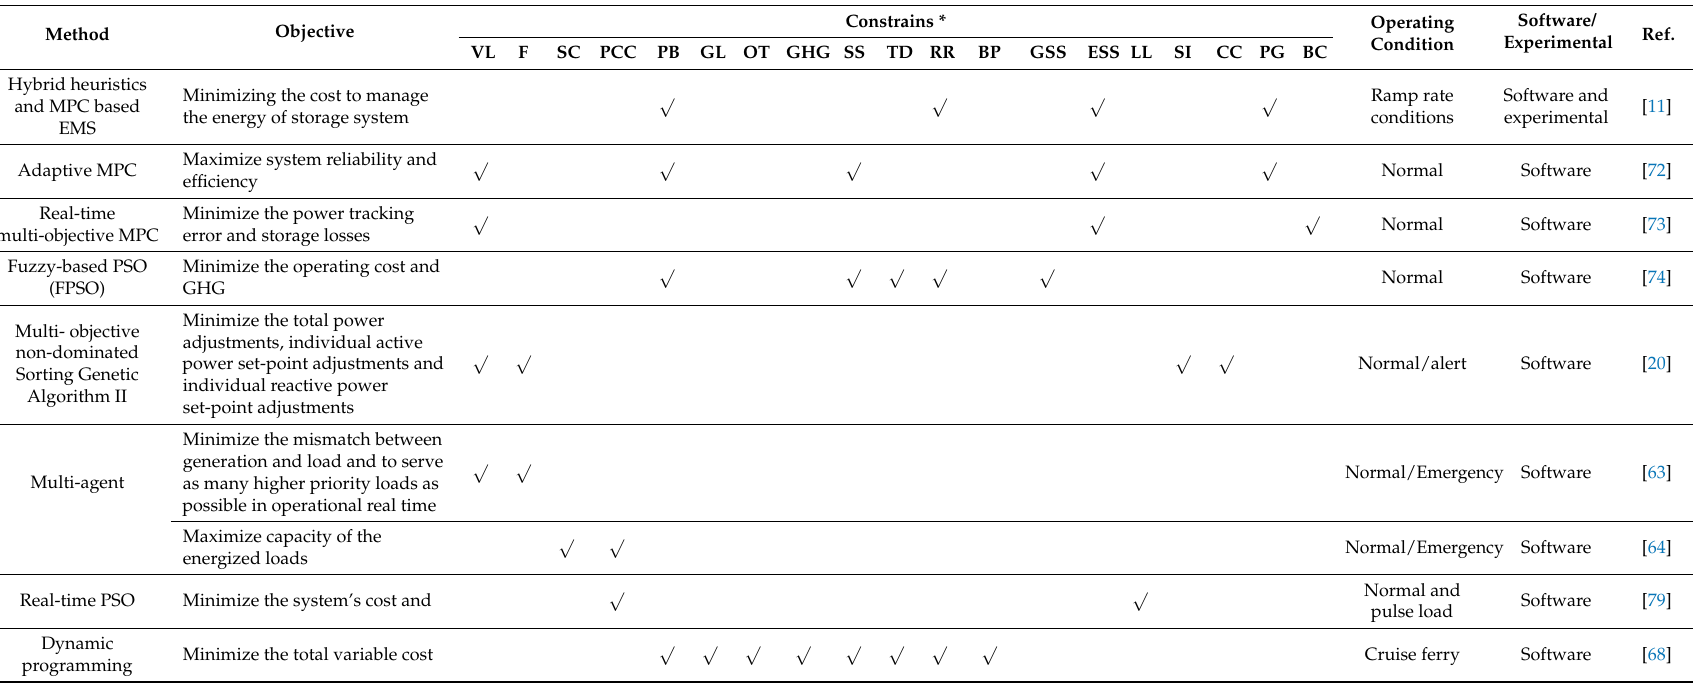
Table 1. Power management methods used in shipboard power